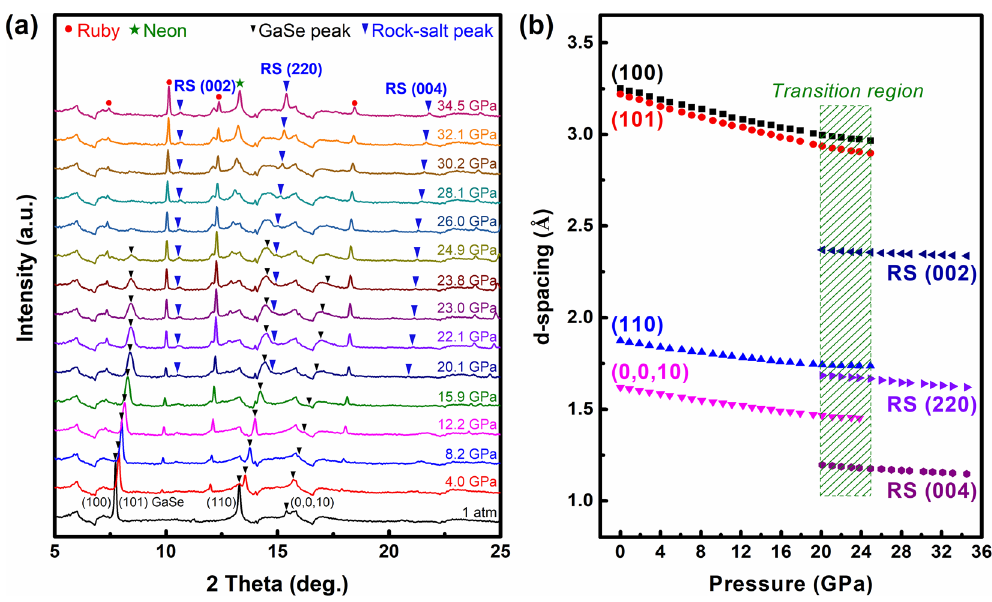
Figure 2. (a) Selected ADXRD spectra of the sub-free SDD-GaSe film during pressurization. (b) Refined d-spacing of the sub-free SDD-GaSe film as a function of applied